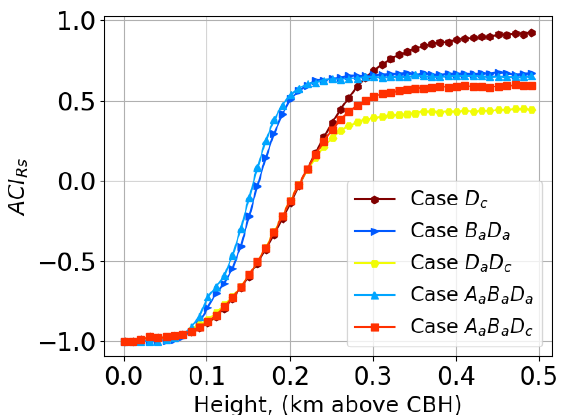
Figure 15. ACI Rs proposal for different cases according to the legend using